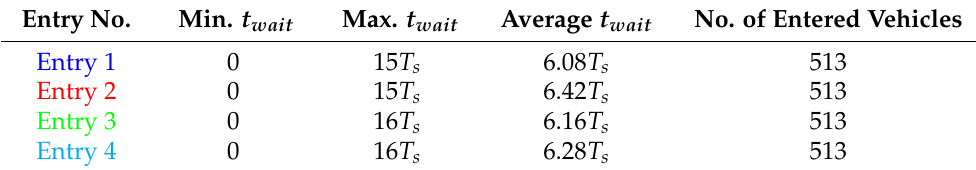
Table 3. Waiting times— fmincon solution.